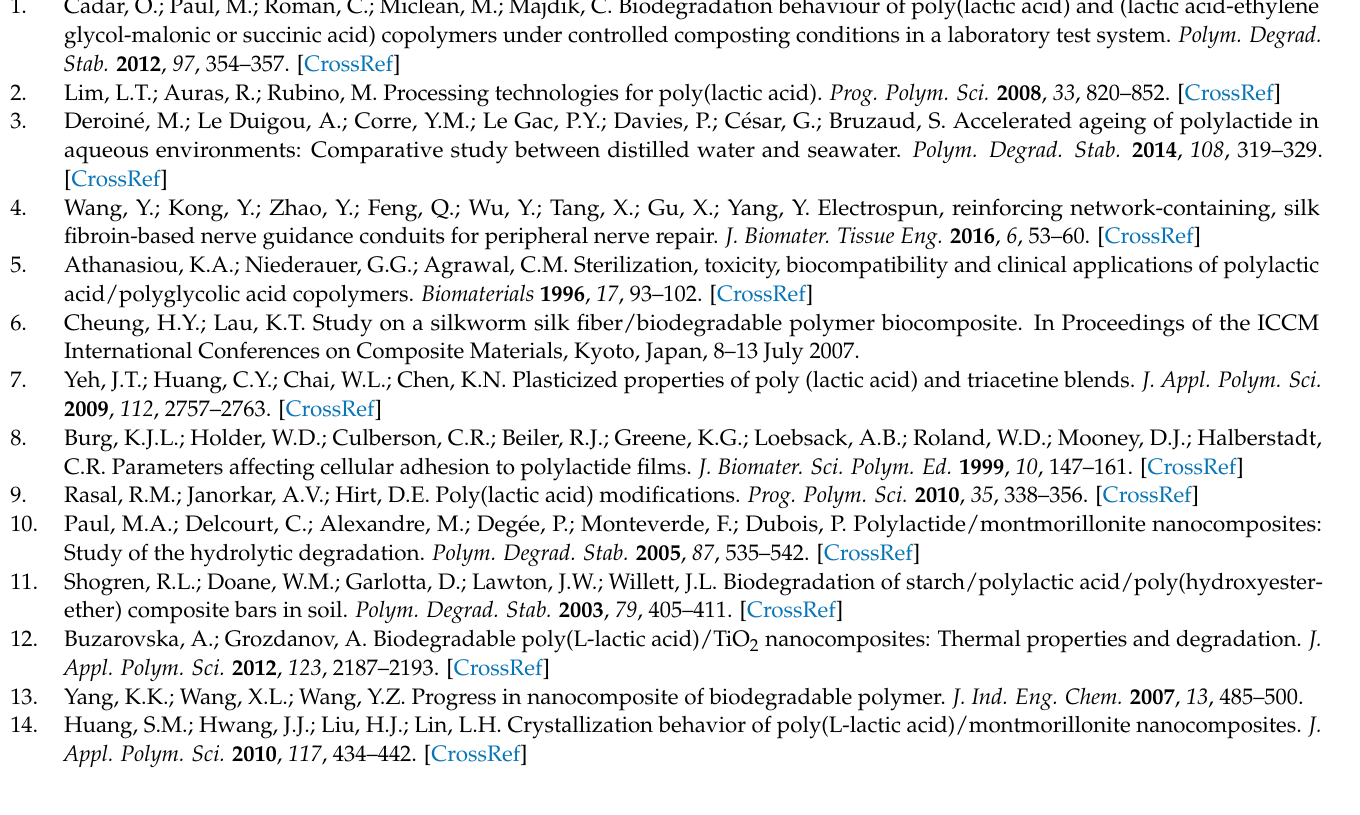
Figure S2: The changes in tensile properties of PLA, PLA/TiO 2 , PLA/SiO 2 , and PLA/Ti x Si y composite films after different periods of in vitro